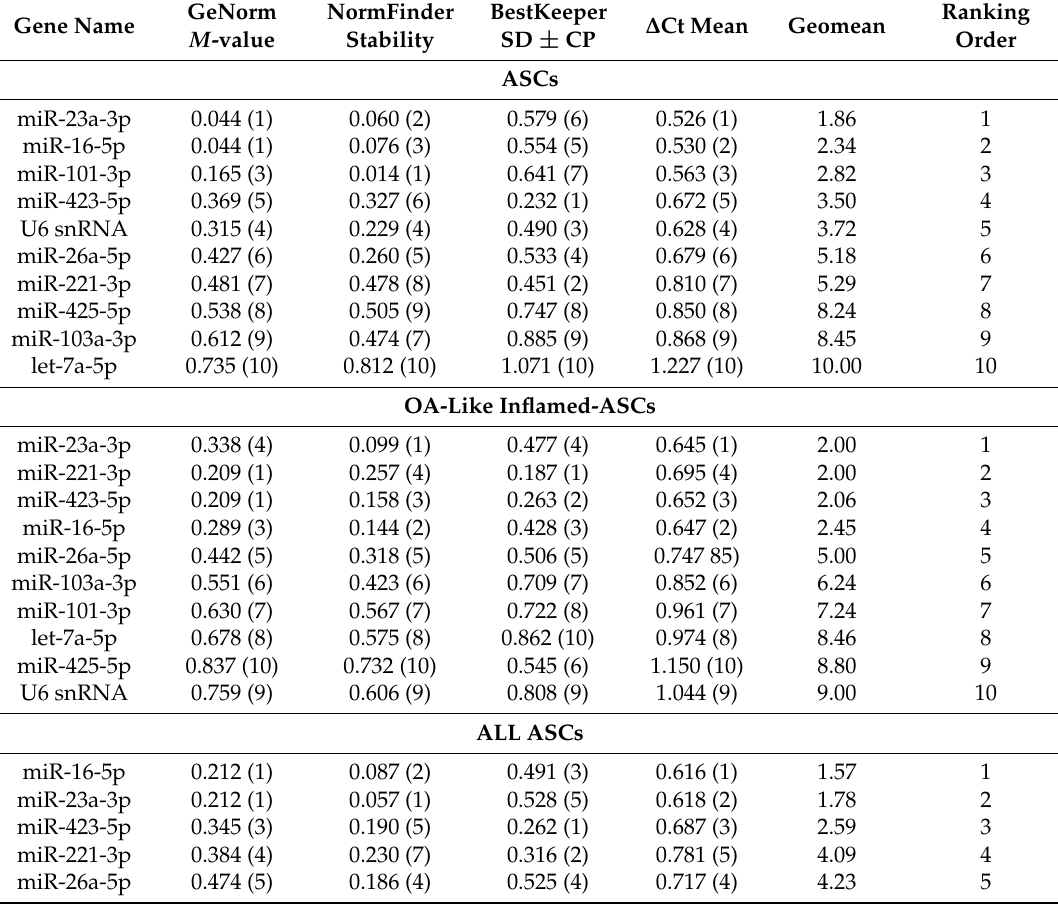
Figure 3. Effects of different reference genes on the normalization of miR-146a-5p expression. Best RGs represents miR16-5p and miR-23a-3p whereas Worst RGs stands for the combination of let-7a-5p and miR-425-5p. ( A ) miR-146a-5p expression in the five ASC-EVs. ASC1-EVs used as reference for statistical significance (ns = not statistically significant; * p -value ≤ 0.05; *** p -value ≤ 0.001; **** p -value ≤ 0.0001). ( B ) Differential expression of miR-146a-5p in OA inflamed vs resting ASC-EVs. ASCs stands for all five samples grouped. Untreated cells used as reference for statistical significance (ns = not statistically significant; # p -value ≤ 0.1; * p -value ≤ 0.05; ** p -value ≤ 0.01). Table 2. Expression levels of candidate reference